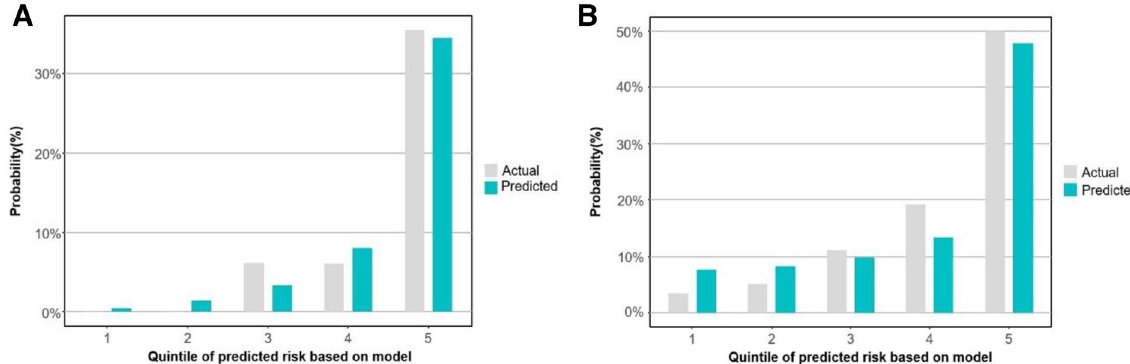
Figure 3. Calibration ability of the severe pneumonia prediction model in patients with Covid-19. The calibration bar plot in the development cohort ( A ) and the validation cohort ( B